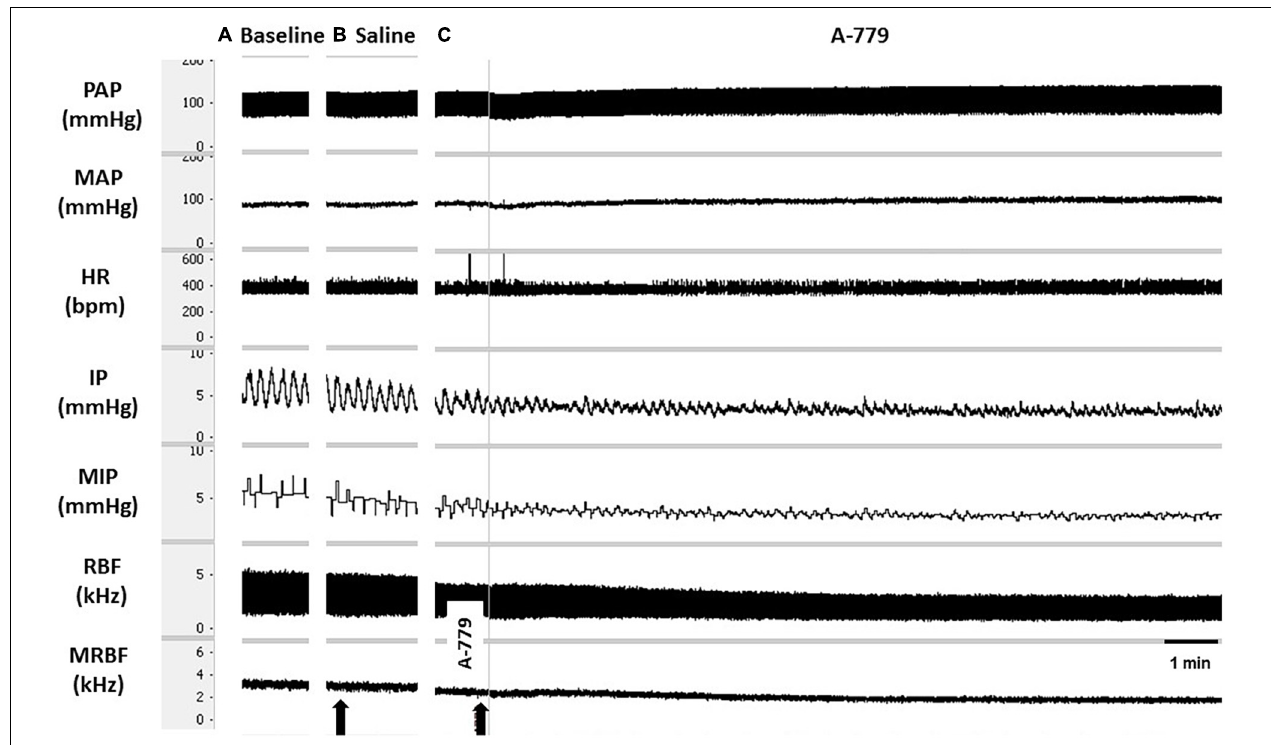
FIGURE 5 | Tracings showing (A) the baseline pulsatile arterial pressure (PAP, mmHg), mean arterial pressure (MAP, mmHg), heart rate (HR, bpm), intravesical pressure (IP, mmHg), mean intravesical pressure (MIP, mmHg), renal blood flow (RBF, kHz), and mean renal blood flow (MRBF, kHz), and the responses evoked by (B) unilateral injection of saline (vehicle, 1 µ L) or (C) A-779 (50 nmol/ µ L, Mas receptor antagonist, 1 µ L) into the lateral preoptic area (LPA). Arrows indicate the moment of saline or A-779 injection into the LPA.